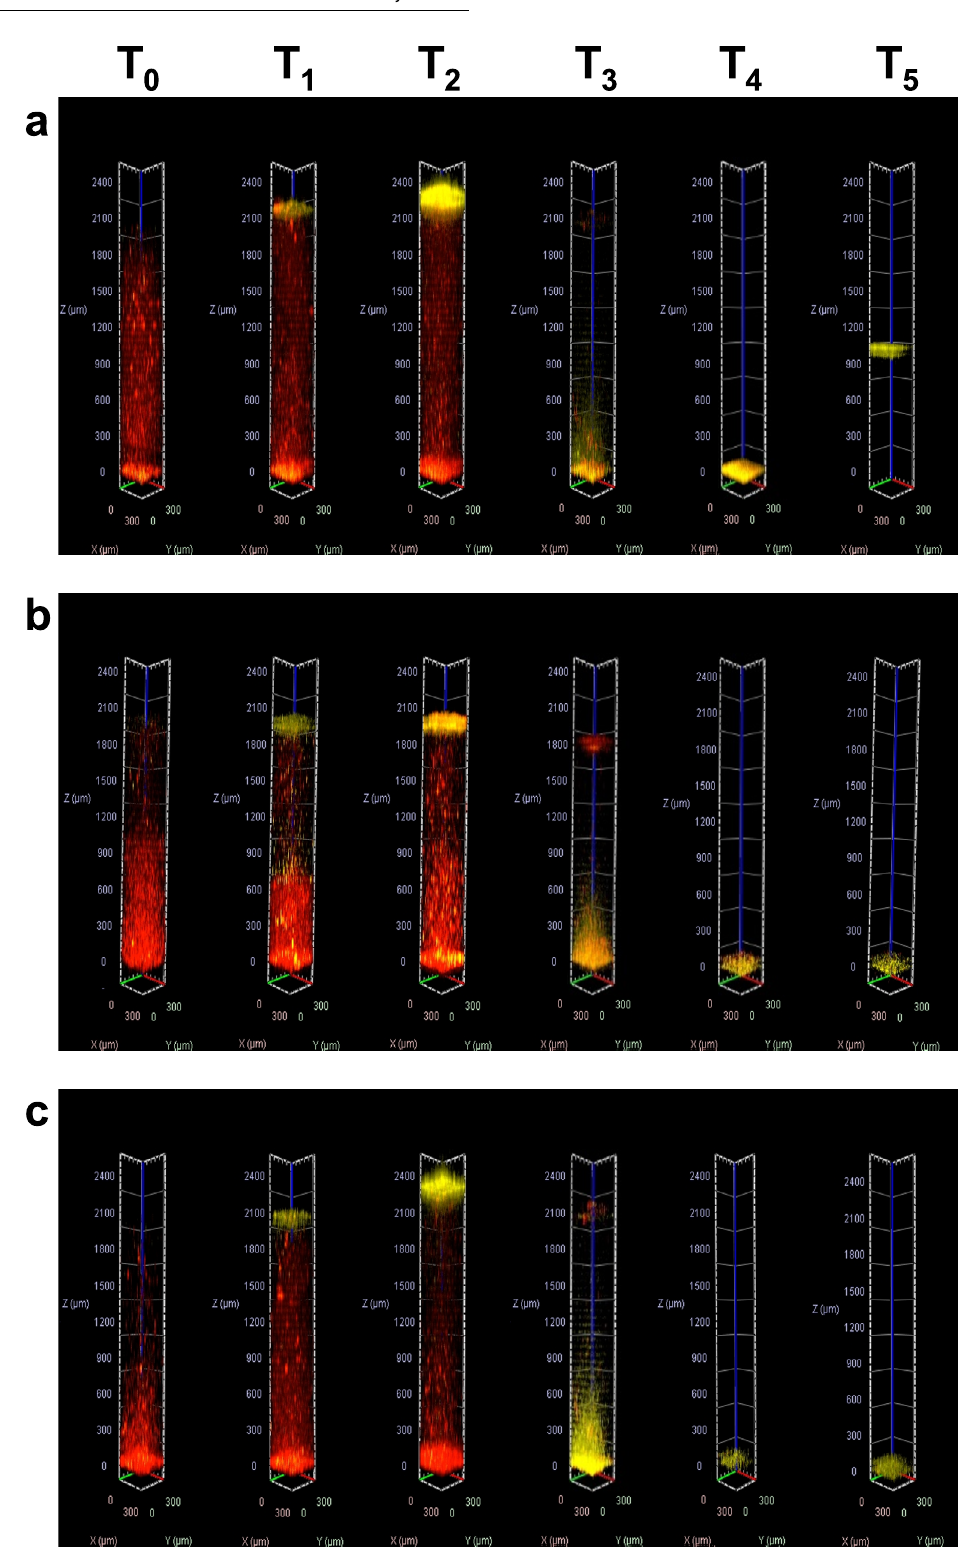
Fig. 4 Systems temporal dynamics of mutant strains . The vertical distributions of B. subtilis PS-216 Δ tasA ( a ), Δ epsA-O ( b ), and Δ epsA-O Δ tasA ( c ) mutant cells at identi fi ed key viscoelastic events ( T 0 – T 5 ). The columns were constructed by stacking optical slices as described for the wild type in Fig.